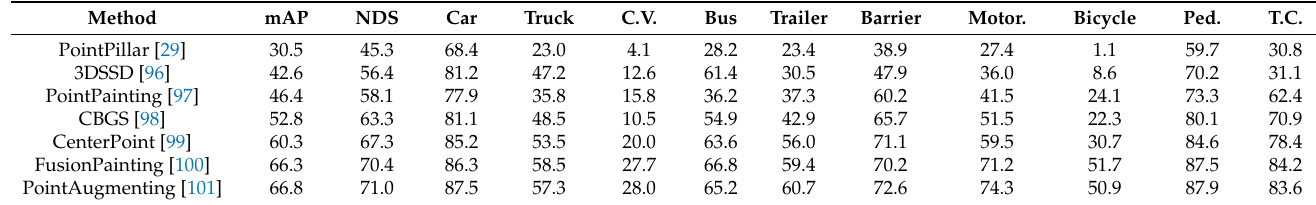
Table 3. Performance comparison on the nuScenes test